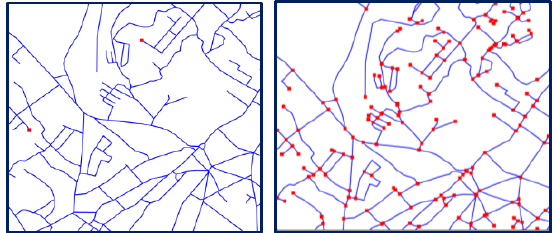
Figure 12: Road network without and with Nodes at